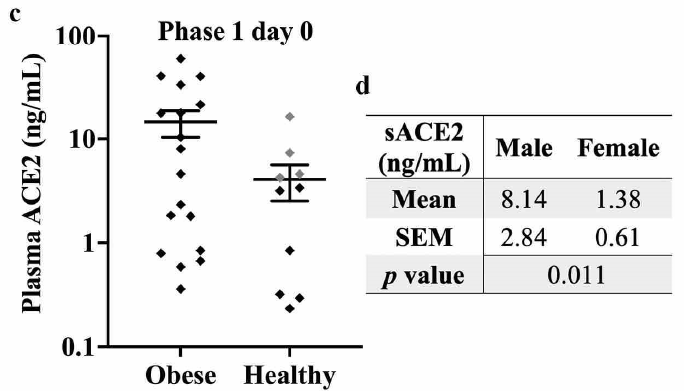
Figure 3. Circulating sACE2 was not affected by n3-PUFA supplementation. ELISA-quantified plasma levels of sACE2 in human subjects before and after receiving 4-week supplementation of either ( a ) 4 g ALA/d or ( b ) 4 g DHA/d in a randomized cross-over design with 4-to-6-week washout between supplementation phases. No significant effect of supplementation was detected (11.55 ± 3.11 vs. 11.86 ± 3.22, before and after ALA supplementation, respectively; 10.80 ± 3.00 vs. 11.59 ± 3.05, before and after DHA supplementation, respectively). ( c ) Baseline (Phase 1, Day 0) sACE2 levels from obese (BMI > 30 kg/m 2 ) and healthy subgroups (BMI between 18 and 28 kg/m 2 ; 14.54 ± 4.17 vs. 4.08 ± 1.56, respectively) with no statistically significant difference detected between the 2 groups ( p = 0.109). ( d ) Sex differences of baseline sACE2 in the healthy subgroup. Individual data points were plotted; grey data points are male subjects and black ones are female subjects. Overall, n = 29 participants for both ( a , b ), n = 18 for obese and n = 10 for healthy in ( c ), and n = 4 for males and n = 6 for females in ( d ).